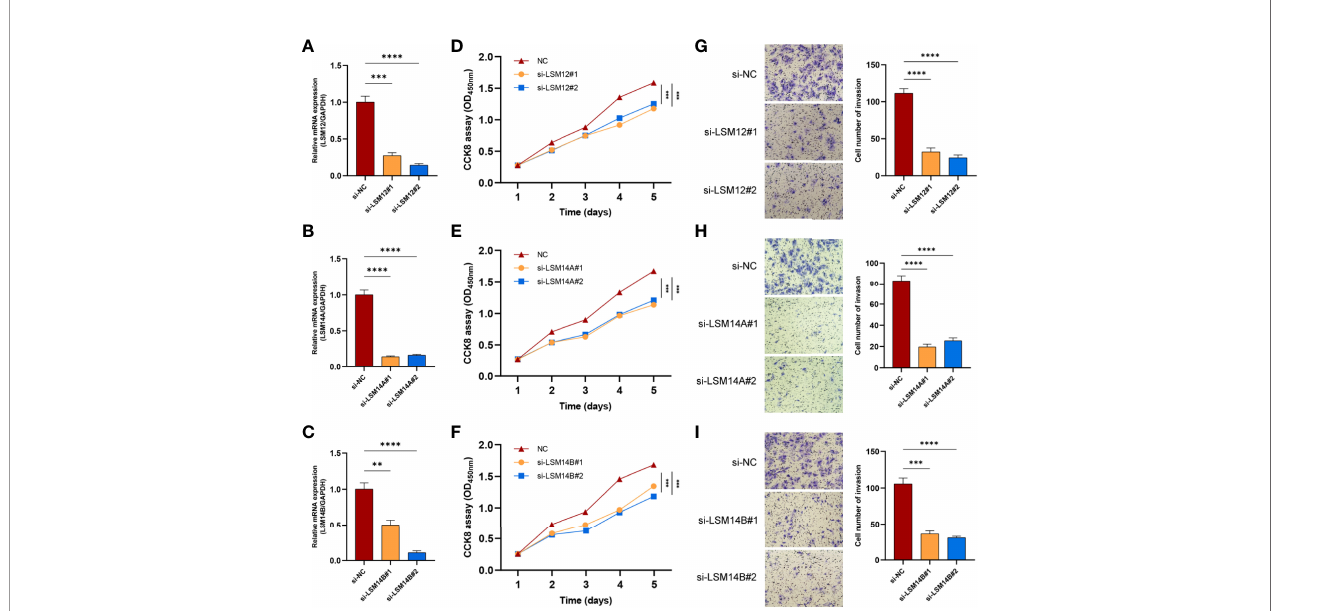
FIGURE 9 | The knockdowns of LSM12, LSM14A, and LSM14B suppress the proliferation and invasion of HCC cells. (A – C) qRT-PCR analysis evaluated the ef fi cacies of si-LSM12/14A/14B RNAs in SNU-387 cell. (D – F) Assessment of tumor cell proliferation using the CCK8 assay. (G – I) Assessment of the invasive capacity of SNU-387 cells using transwell invasion assay. **P-value <0.01; ***P-value <0.001; ****P-value